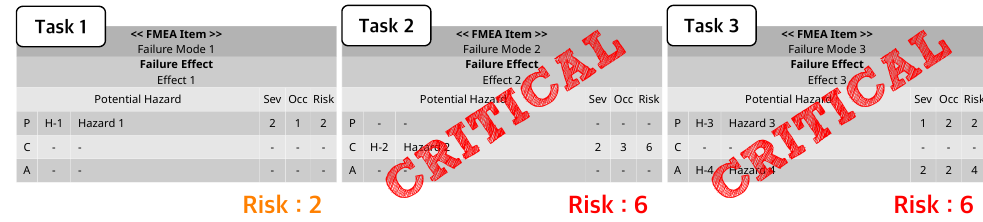
Figure 3. Critical task